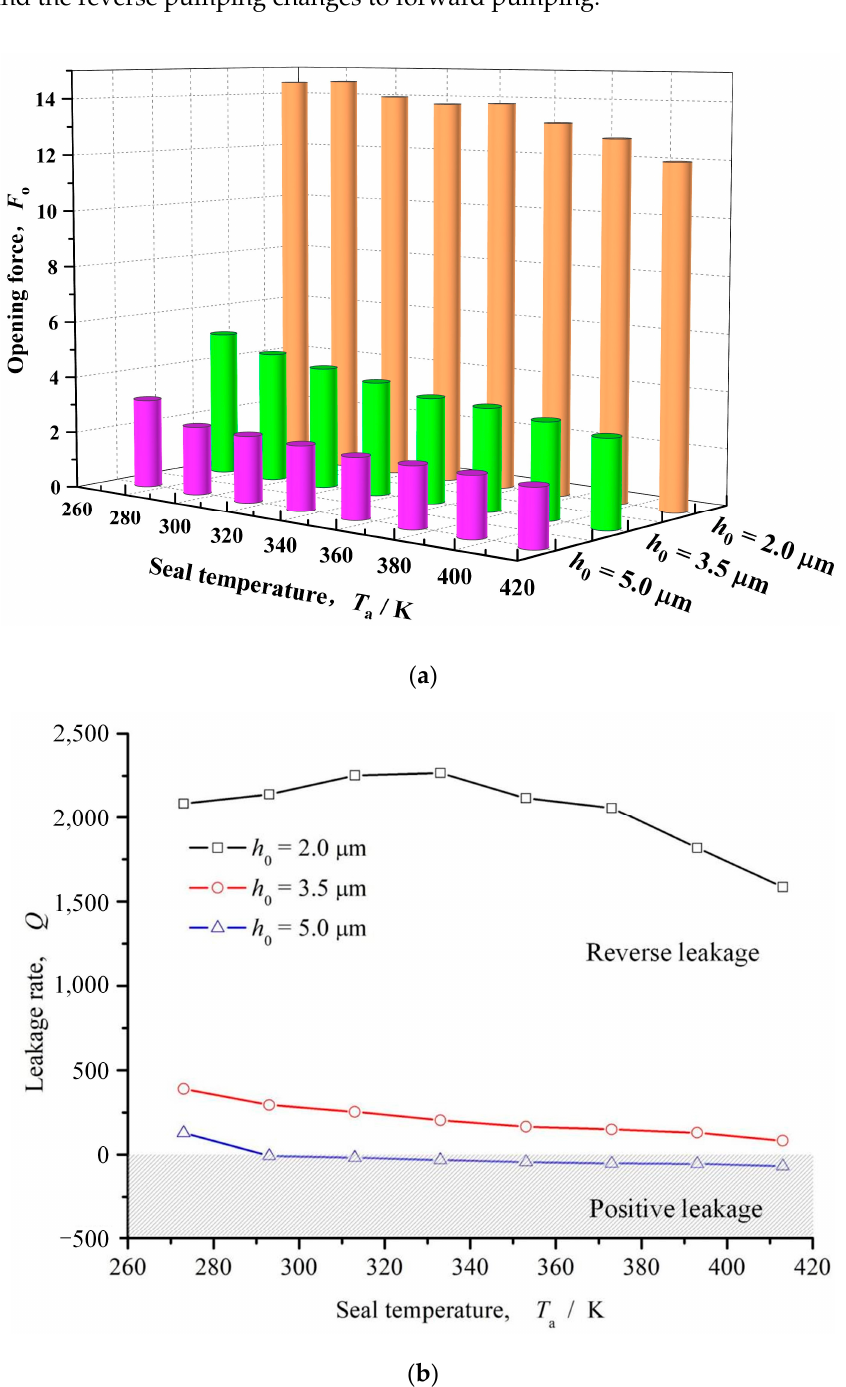
Figure 10. In fl uence of seal temperature on opening force and leakage rate ( ω = 12,000 rpm, P o = 4, h 0 = 2 μ m, h d = 5 μ m, γ = 3, α = 45°, N = 80). ( a ) Opening force; ( b ) Leakage